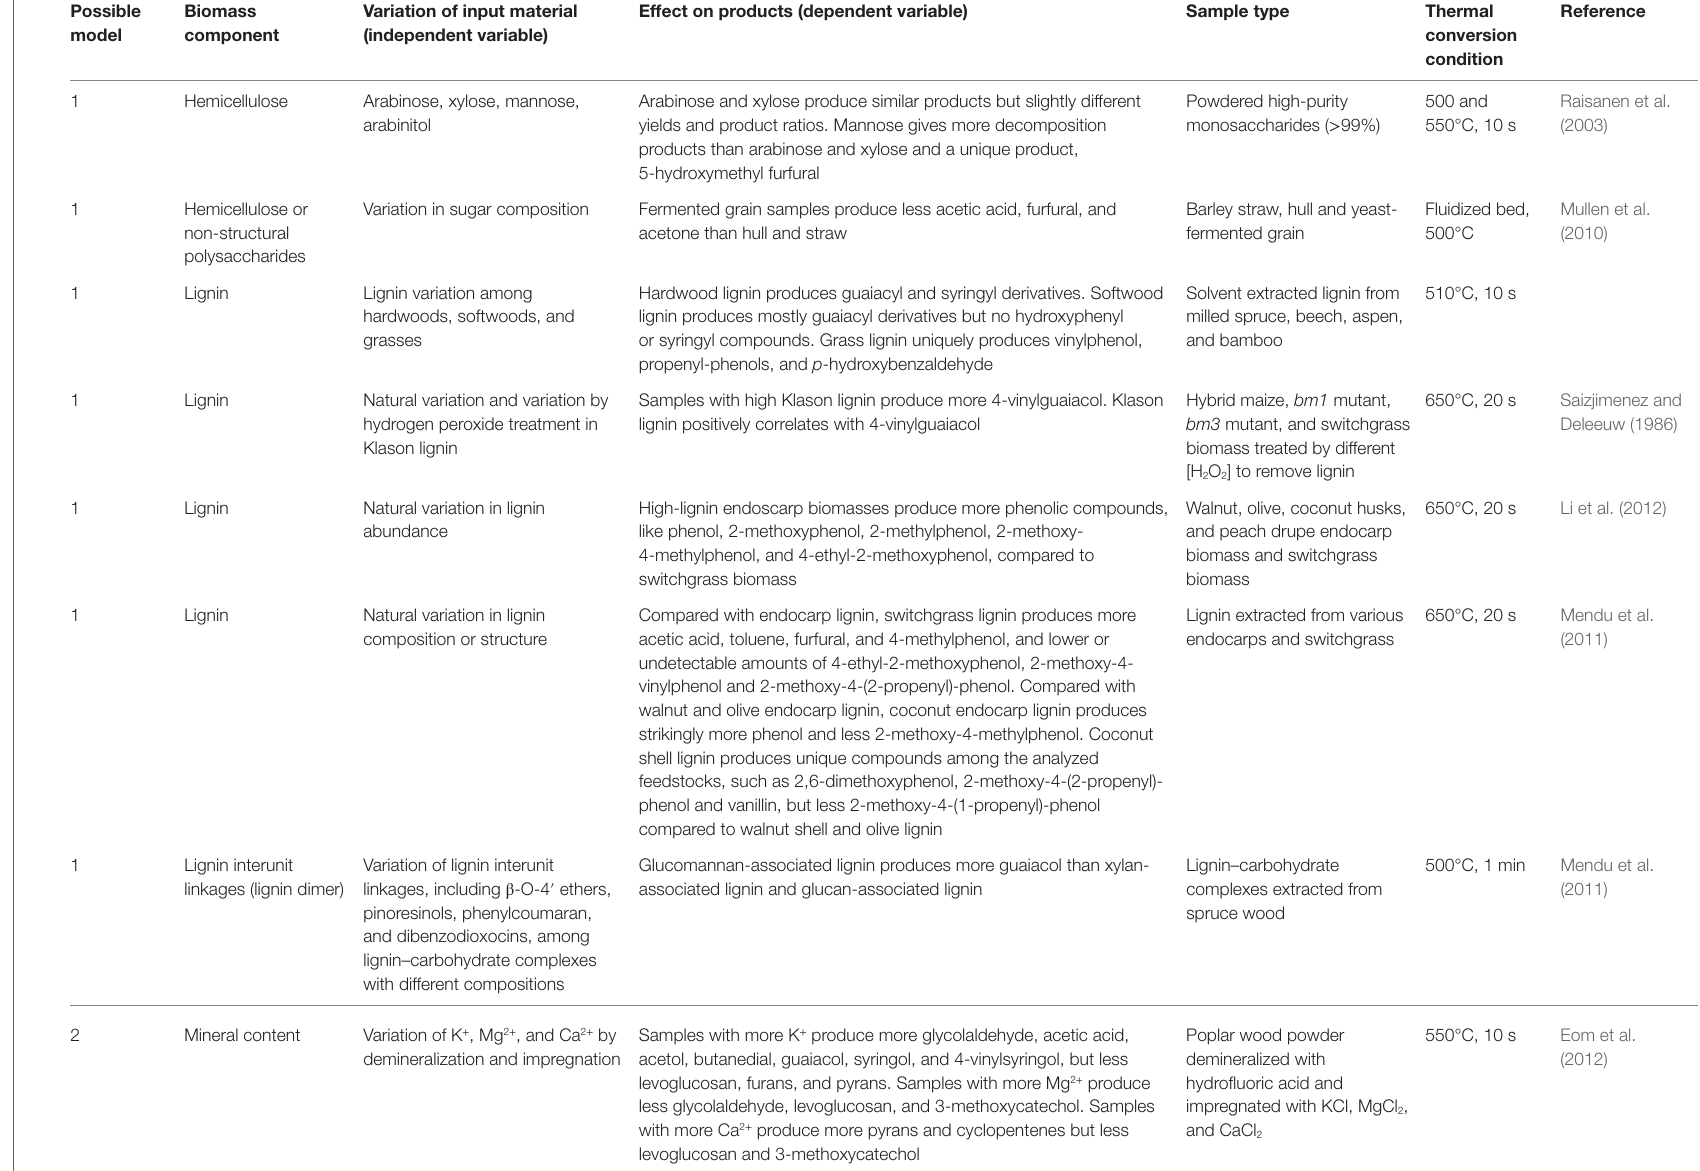
TABLe 3 | Possible models of how biomass components affect the composition and yield of liquid thermal